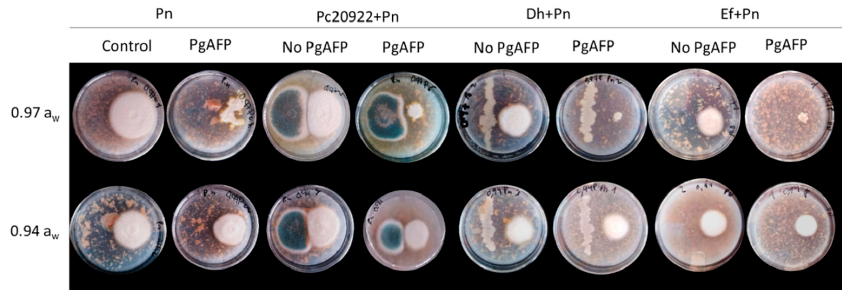
Figure 2. Interactions of the three biocontrol agents ( Enterococcus faecium SE920, Debaryomyces hansenii FSHCC 253H, and Penicillium chrysogenum CECT 20922) with the native dry-cured meat product mold Penicillium nalgiovense FSHCC Pj261 at 0.97 and 0.94 water activity ( a w ) after 7 days at 25 °C in the presence and absence of the antifungal protein PgAFP in a dry-cured fermented sausage (salchich ó n)-based medium. Treatments: Control: P. nalgiovense FSHCC Pj261 inoculated without biocontrol agents; Pn: P. nalgiovense FSHCC Pj261; Pc20922: P. chrysogenum CECT 20922; Dh: D. hansenii FSHCC 253H; Ef: E. faecium SE920. No PgAFP: PgAFP was not added; PgAFP: PgAFP was added. The biocontrol agent was inoculated on the left side of the plate and P. nalgiovense FSHCC Pj261 on the right side of the